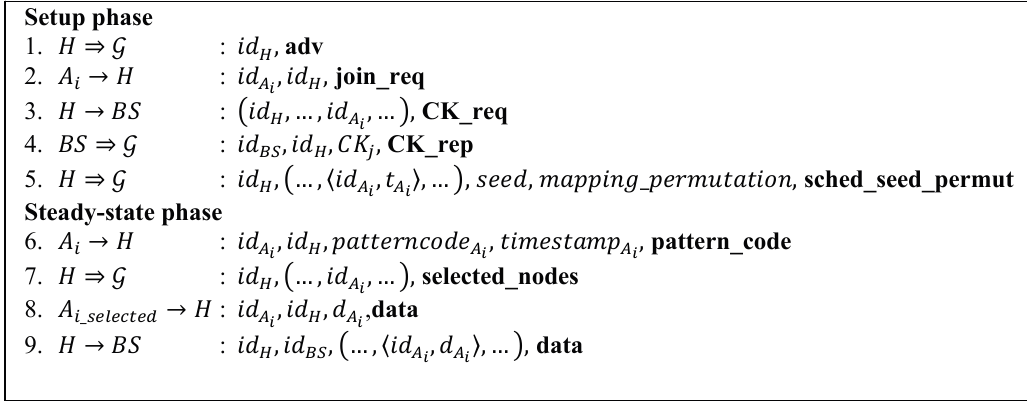
Figure 6. Message flow of the proposed